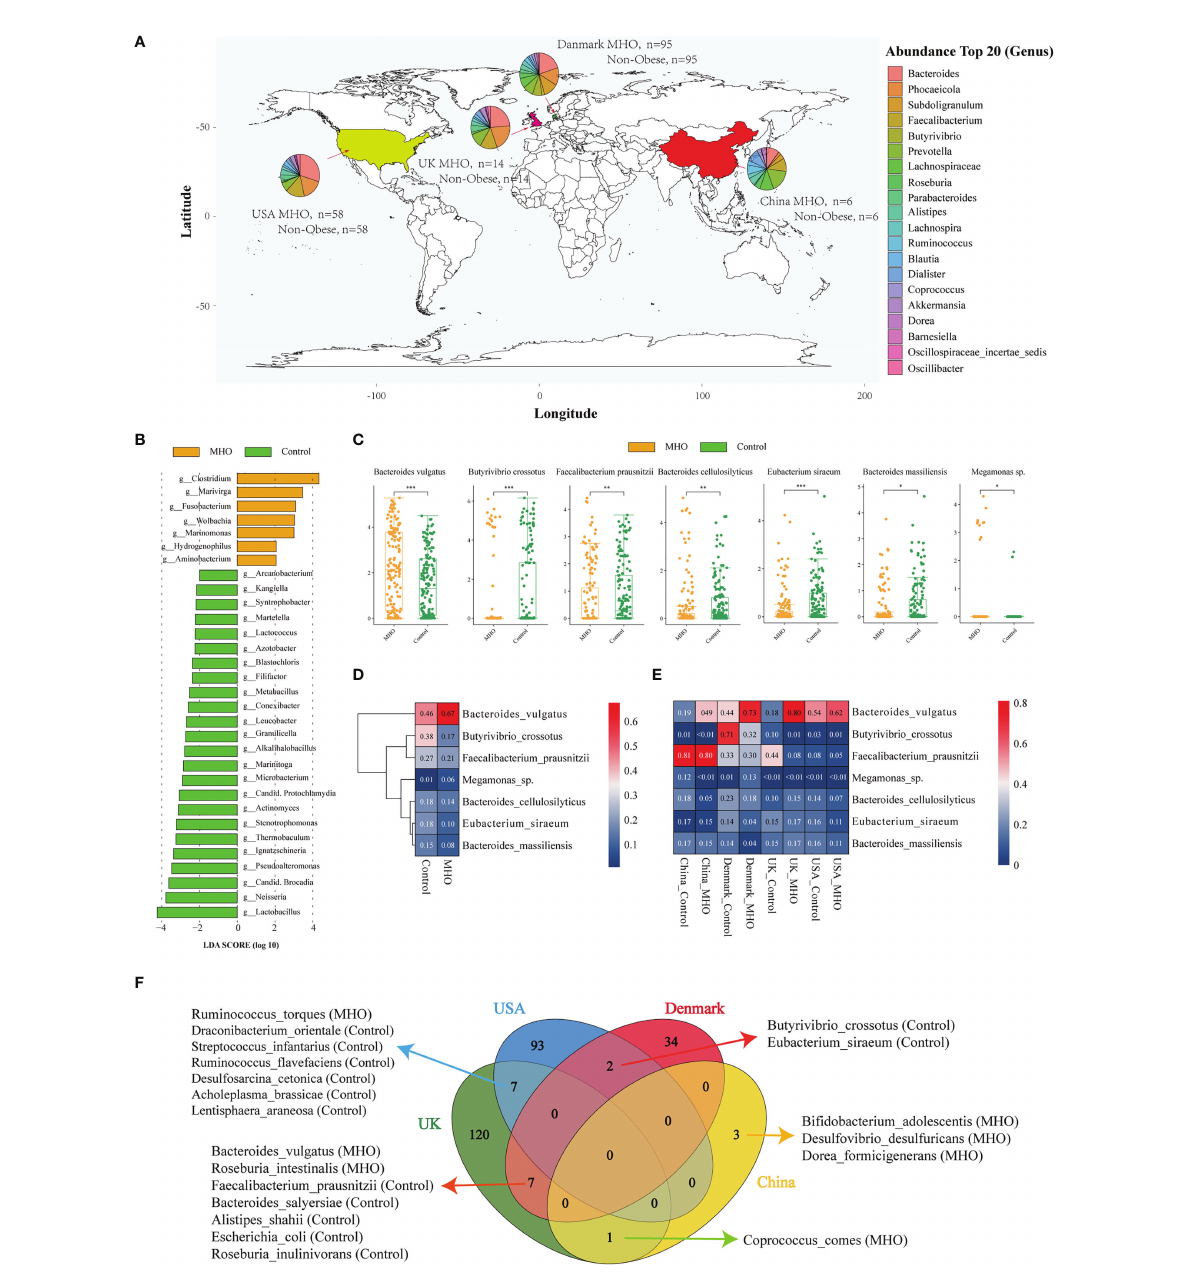
FIGURE 2 Signi fi cantly-changed species in MHO individuals. (A) Geographic distribution of samples from four different projects. Each pie chart represents the composition of the top 20 abundant genera in MHO subjects. (B) LEfSe analysis: Plot of LDA effect size. The length of the bar column represents the LDA score. The fi gure shows the microbial taxa with signi fi cant differences at genus levels between the MHO (Yellow) and Control (green) (LDA score>2.0). (C) The difference of relative abundance in certain species between MHO and controls (Log2 transformed). * p 0.05 ** p 0.01 *** p 0.001. (D, E) Heatmap visualization of the mean abundance in MHO patients and healthy controls based on regional differences. Each column represents one subgroup based on the MHO or control groups in different countries. Each row represents one of the seven species. Values in each square represent the mean relative abundance in percentage (Log 10 transformed). The color scale was set based on the speci fi c value of the mean relative abundance after the Log 10 transformation, with red for relative high abundance and blue for the low ones. (F) Venn diagrams illustrating the number of signi fi cantly enriched or depleted species between MHO and non-obese healthy controls in different countries. The MHO or control in parentheses means the group in which the species was